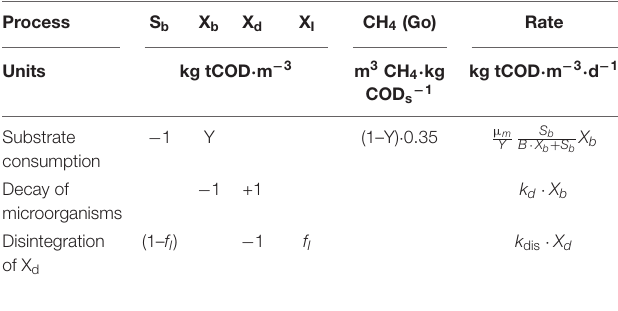
TABLE 4 | Biochemical coefficients and kinetic rate equations for tCOD and VSS in model